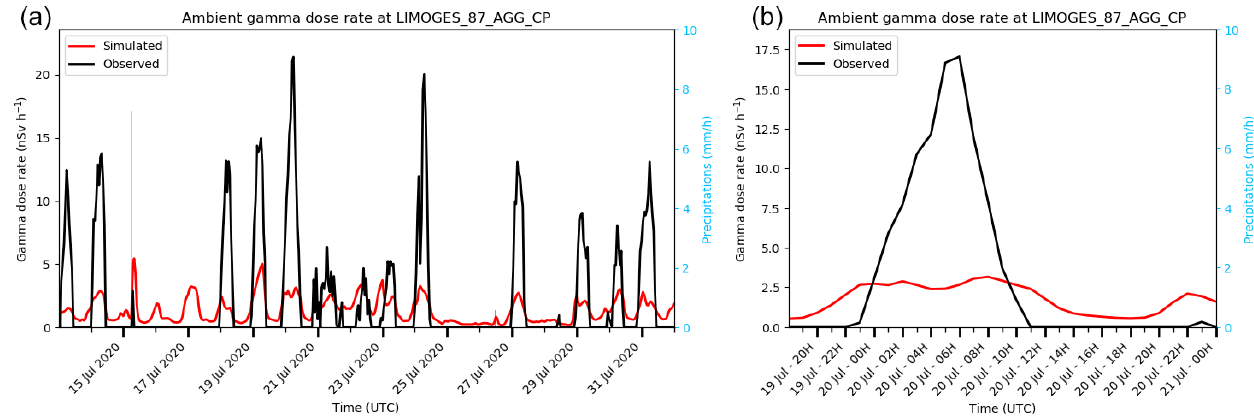
Figure 15. Observed and simulated dose rates at Limoges, illustrating summer nights FN. (a) In July 2020. (b) The 20 July 2020.